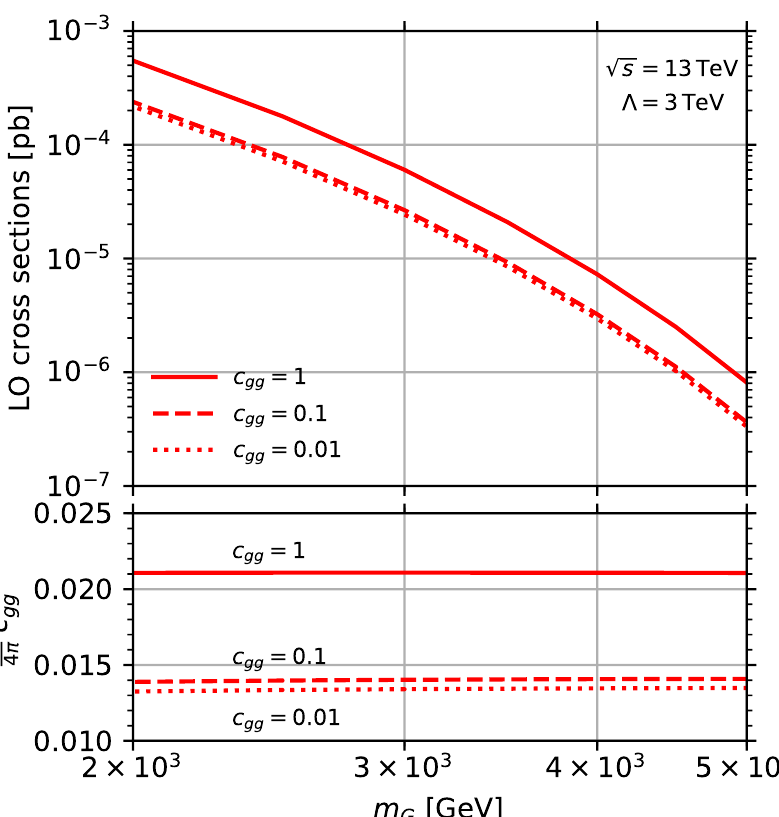
= (4 (cid:25) (cid:3)) gg